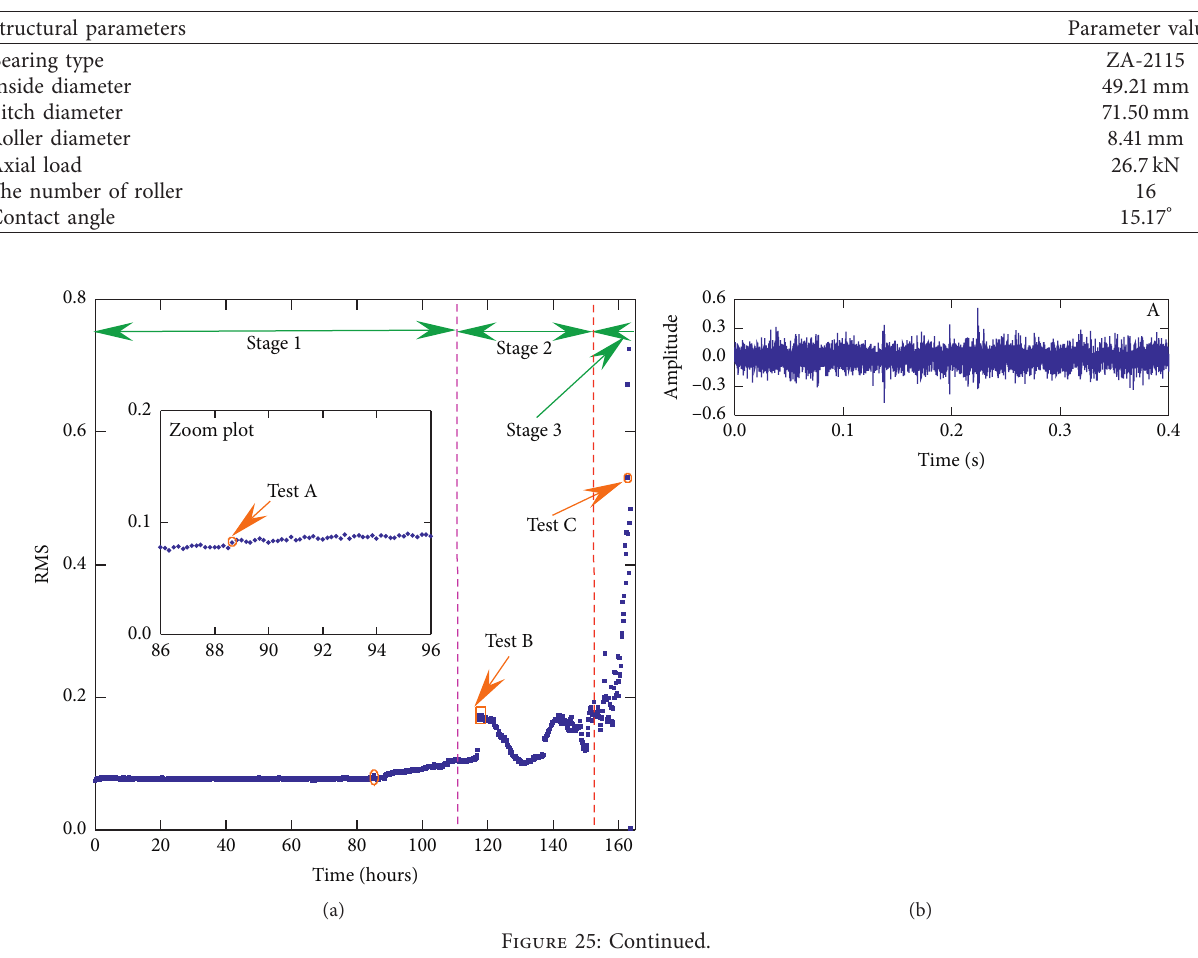
Table 5: Structural parameters of rolling